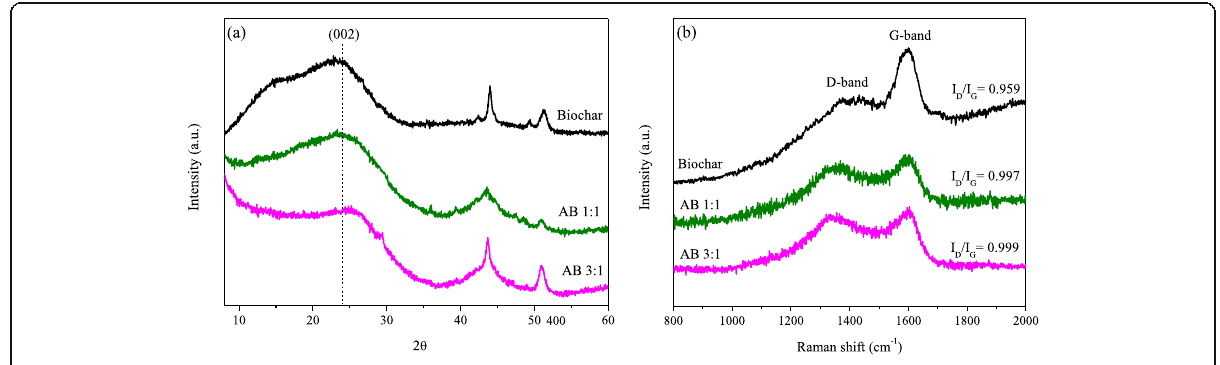
Fig. 8. The presence of surface functional groups is con-